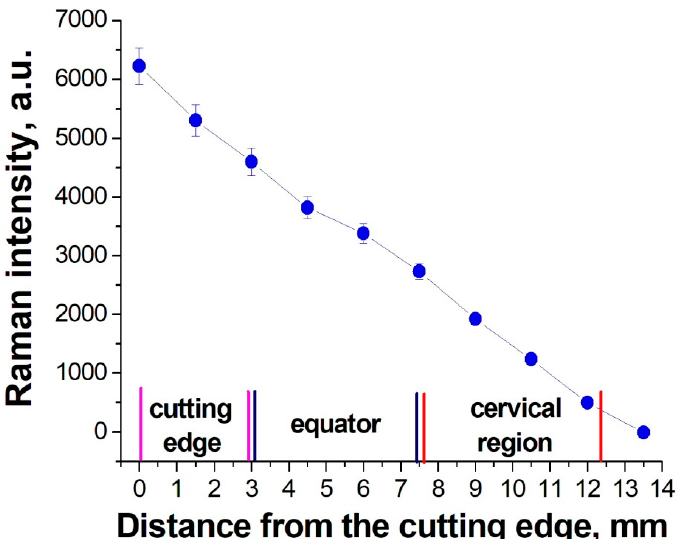
Figure 1. Graph of the Raman scattering intensity dependence on the spatial point on the surface of the molar enamel This dependence was obtained by averaging 50 Raman line scans (on 1 molar) with a scan step of 1.5 mm. The laser excitation wavelength is 1064 nm, the exposure time is 4 s, and the number of frames for recording a single spectrum is 10.